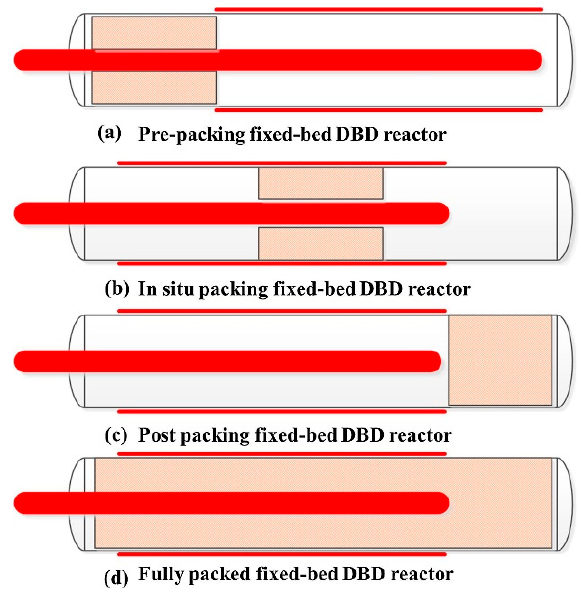
Figure 7. Different reactor configurations based on the packing material. ( a ) Pre-packing fixed-bed DBD reactor; ( b ) in situ packing fixed-bed DBD reactor; ( c ) post packing fixed-bed DBD reactor; ( d ) fully packed fixed-bed DBD reactor. Reproduced with permissionfrom [8], Copyright 2019, Elsevier.